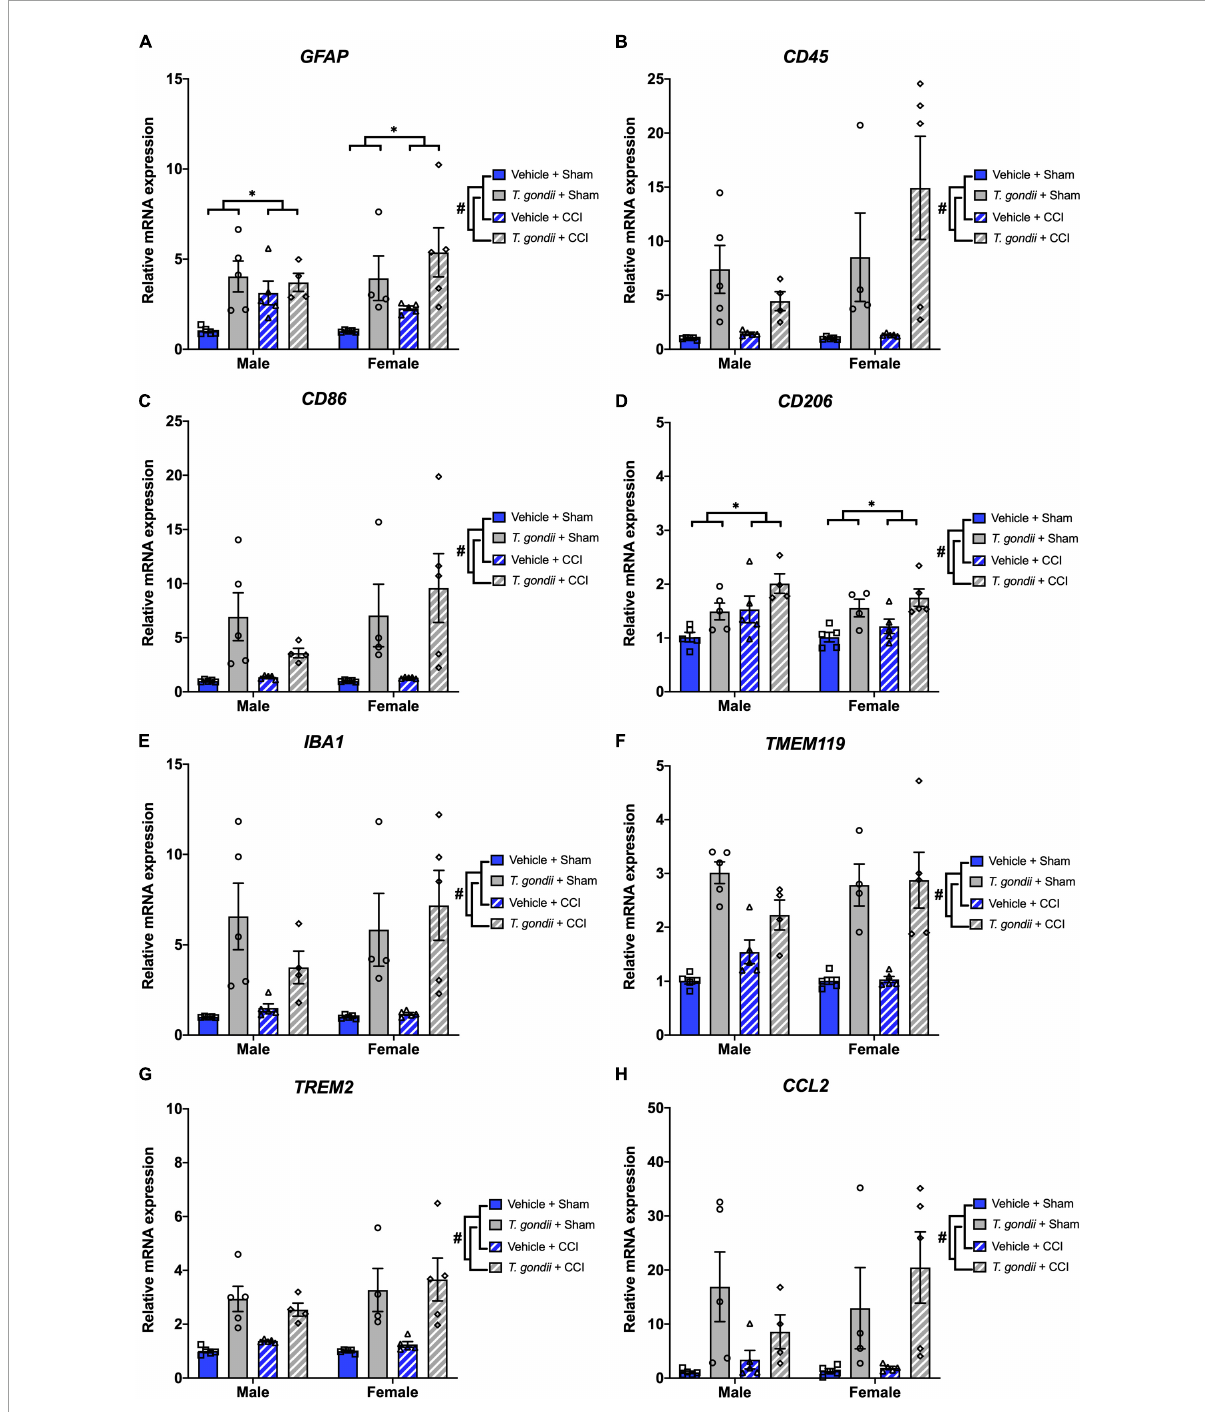
FIGURE4 Toxoplasma gondii infection increased leukocyte and glial cell gene expression in the ipsilateral cortex of mice chronically post-controlled cortical impact (CCI). Gene expression of GFAP (A) , CD45 (B) , CD86 (C) , CD206 (D) , IBA1 (E) , TMEM119 (F) , TREM2 (G) , and CCL2 (H) was increased in T. gondii infected mice compared to vehicle mice. Gene expression of GFAP (A) and CD206 (D) was also increased in mice that received a CCI compared to sham-injured mice. # T. gondii -infected mice significantly differ from vehicle mice, ∗ CCI mice significantly differ from sham-injured mice, p < 0.05. n = 4–5/group/sex. Data shown is mean ±